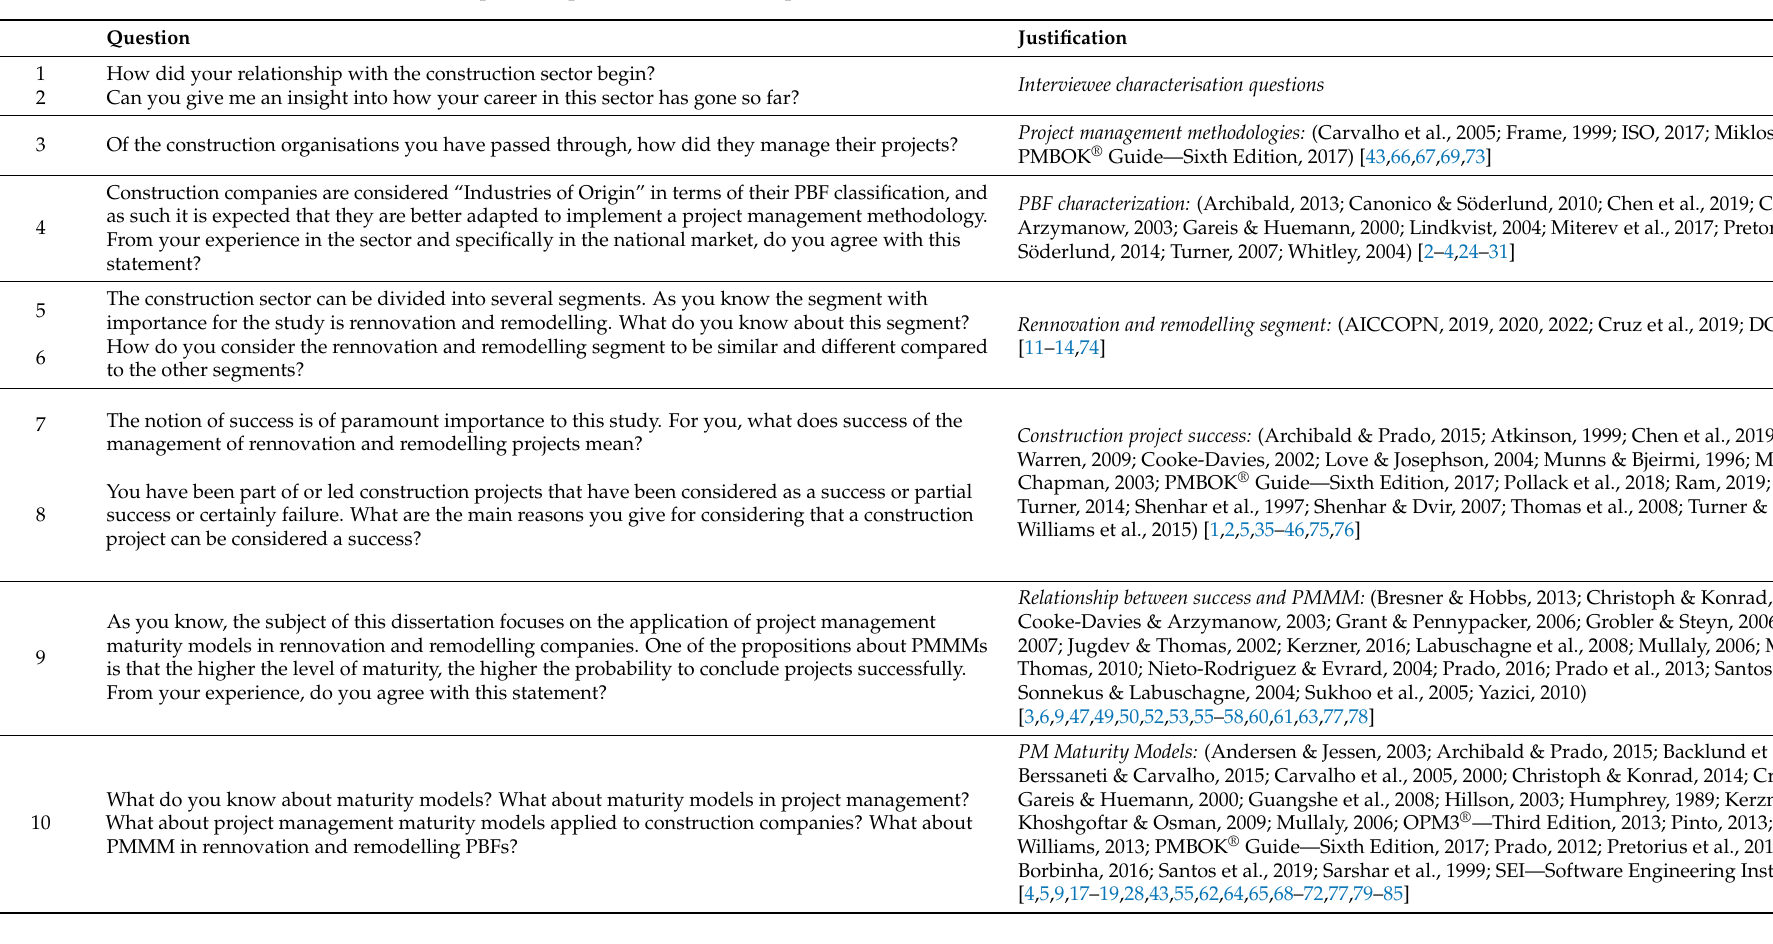
Table A4. Conceptual map of the interview